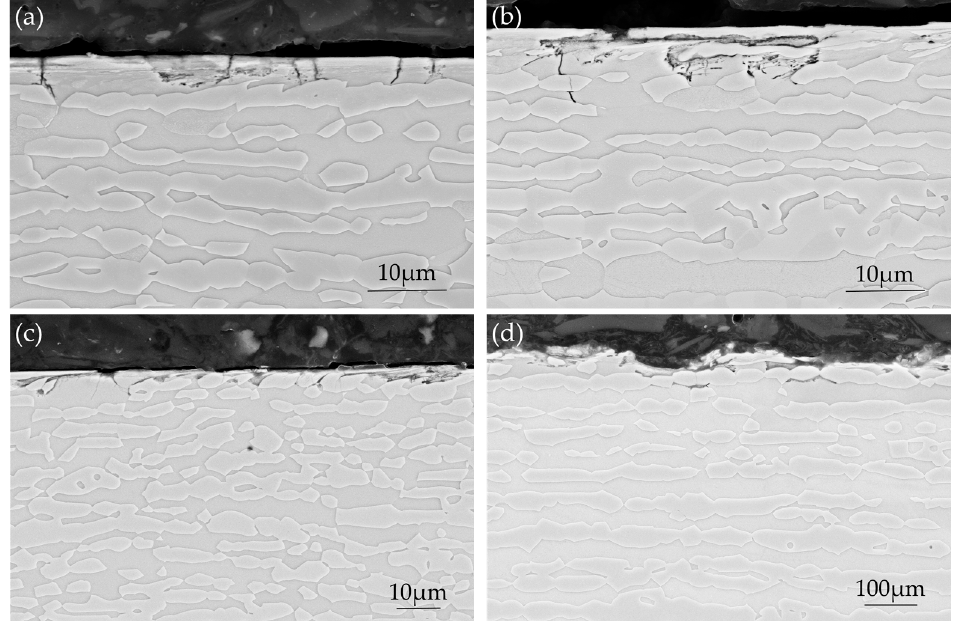
Figure 7. Cross-section microstructures after exposure without external loading: ( a , b ) Ground-RD specimen sectioned parallel to rolling direction; ( c ) Ground-TD specimen sectioned perpendicular to rolling direction; and ( d ) Ground-TD specimen sectioned parallel to rolling direction.